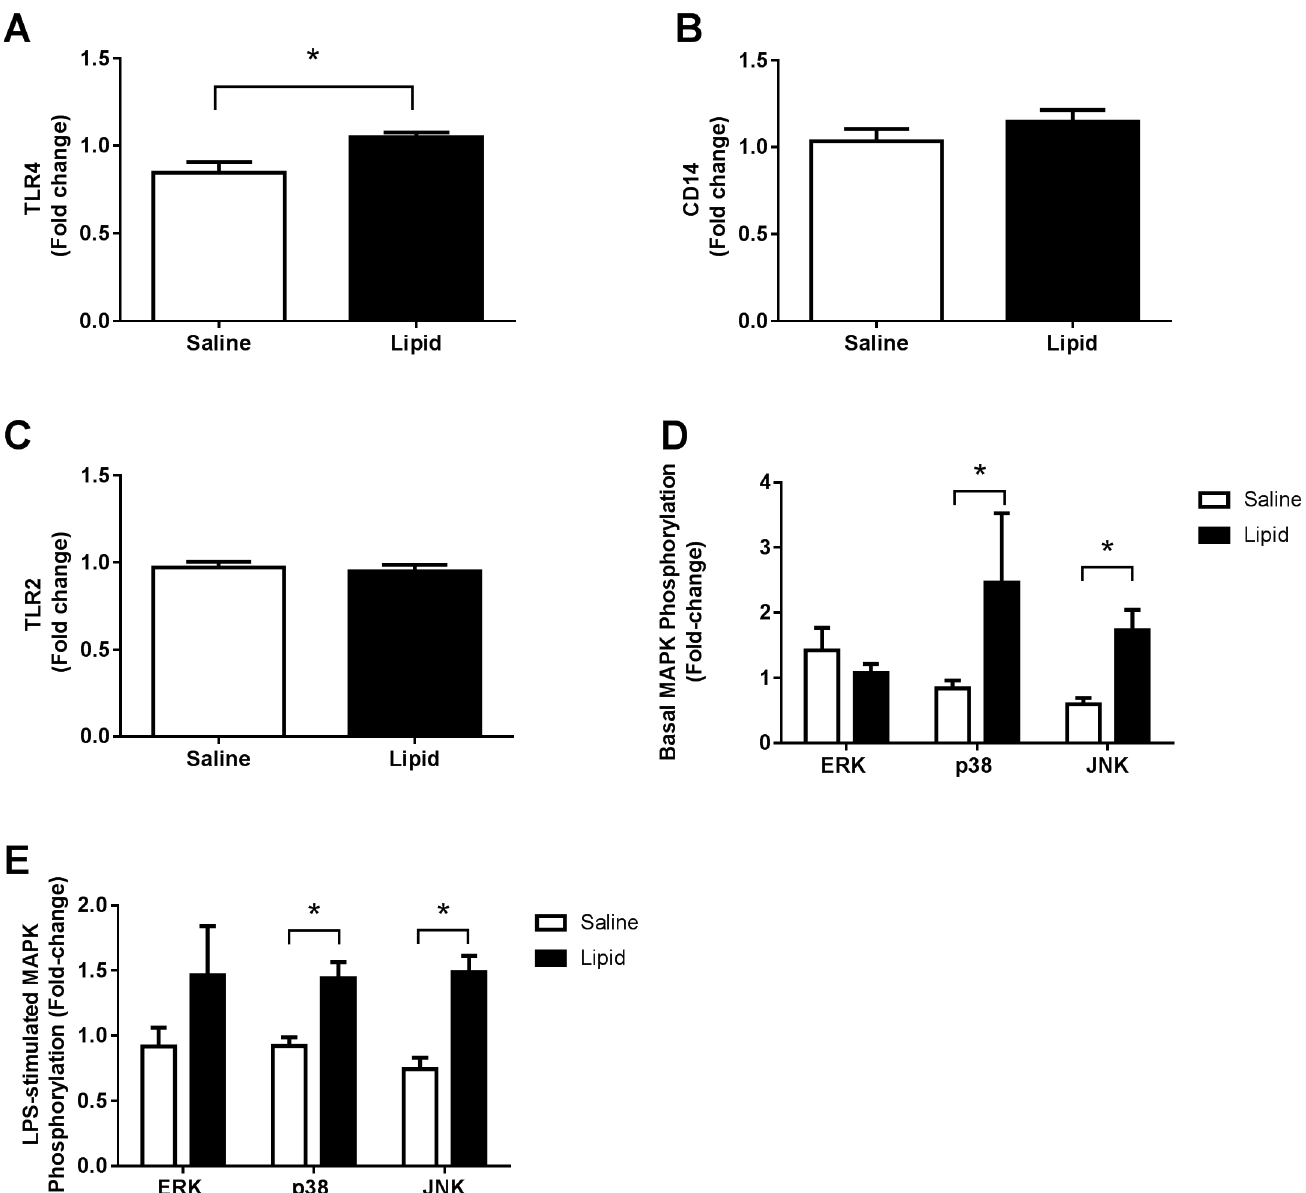
Fig 1. Effect of lipid infusion on TLR cell surface expression and intracellular MAPK phosphorylation in peripheral blood monocytes. Cell surface protein levels of TLR4 (A), CD14 (B) and TLR2 (C) and basal (D) and LPS-stimulated (E) MAPK phosphorylation were determined by flow cytometry as described under ‘Materials and methods’. All values are the mean ± SEM of data obtained from 10–12 subjects. (cid:3) P < 0.05.